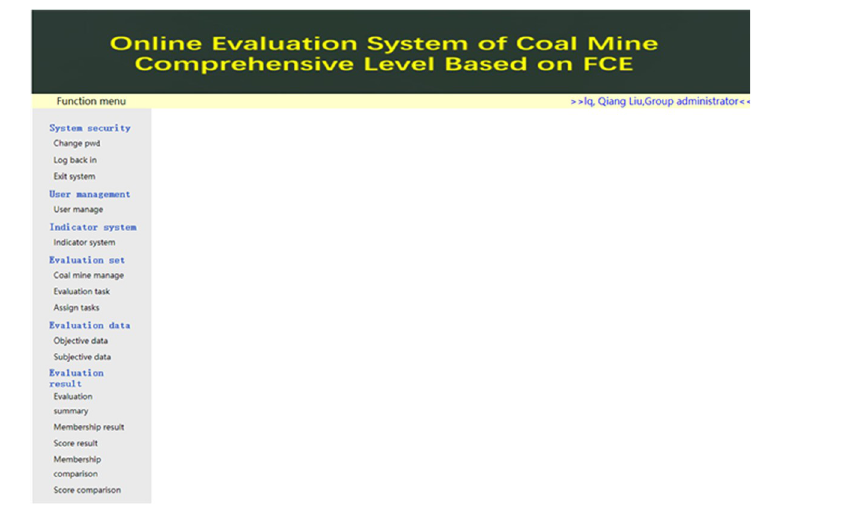
Fig 7. Main interface of Group administrator.